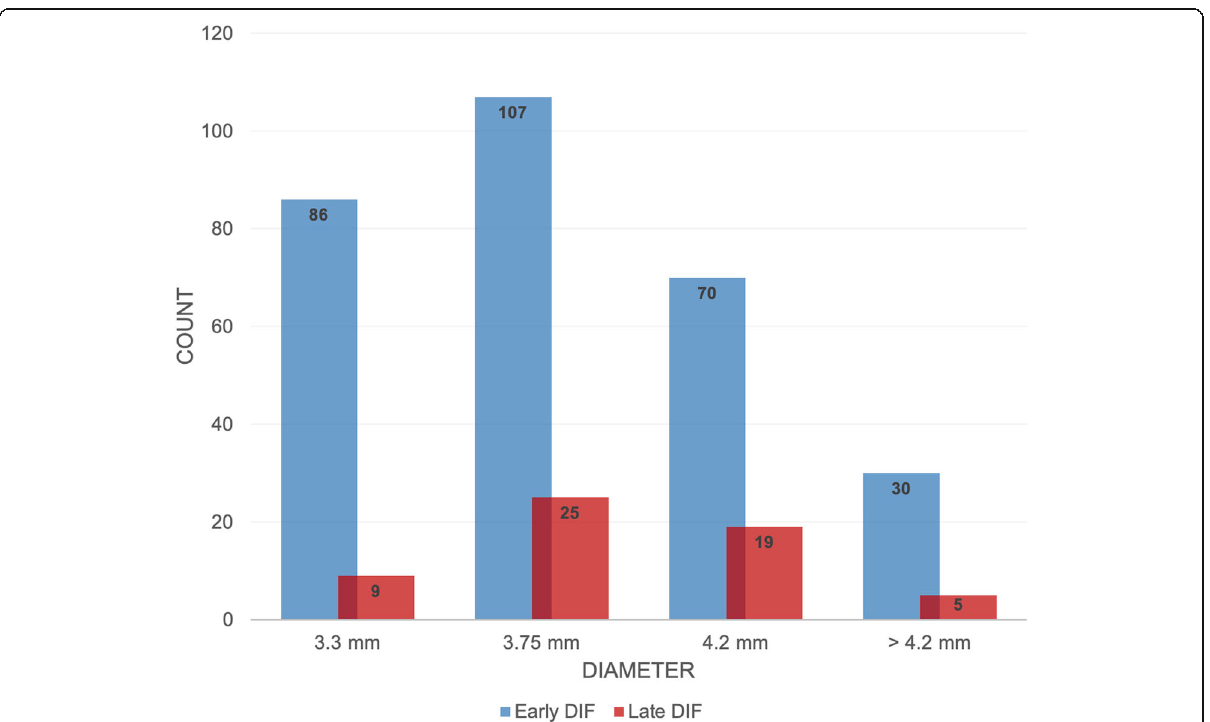
Fig. 4 Frequency of early and late dental implant failure among implants of different diameter. Groups of different diameters displayed no significant correlation ( χ 2 = 2.510, p = 0.474, Cramers V = 0.085). Implants of smaller diameter showed higher frequencies of early events (3.3mm: n = 72, 20.5%; 3.5mm: n = 88, 25.1%; 4.2mm: n = 62, 17.7%) and a maximum frequency of late losses in implants of 3.75mm ( n = 44, 12.5%) with no statistically